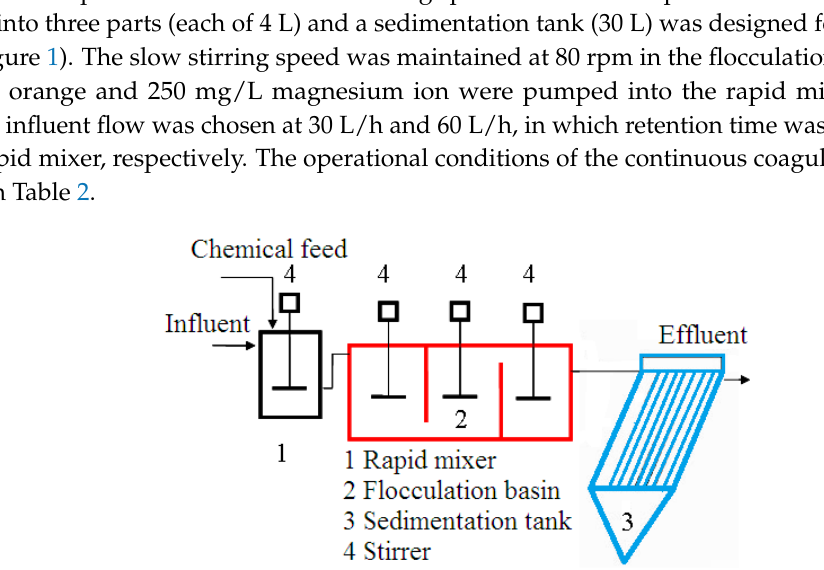
Figure 1. Experimental apparatus for coagulation of magnesium hydroxide.